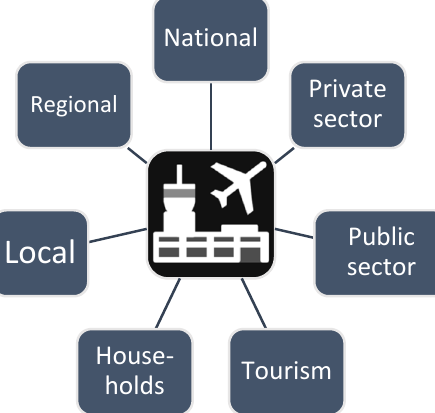
Figure 1. Generic airport stakeholder map.